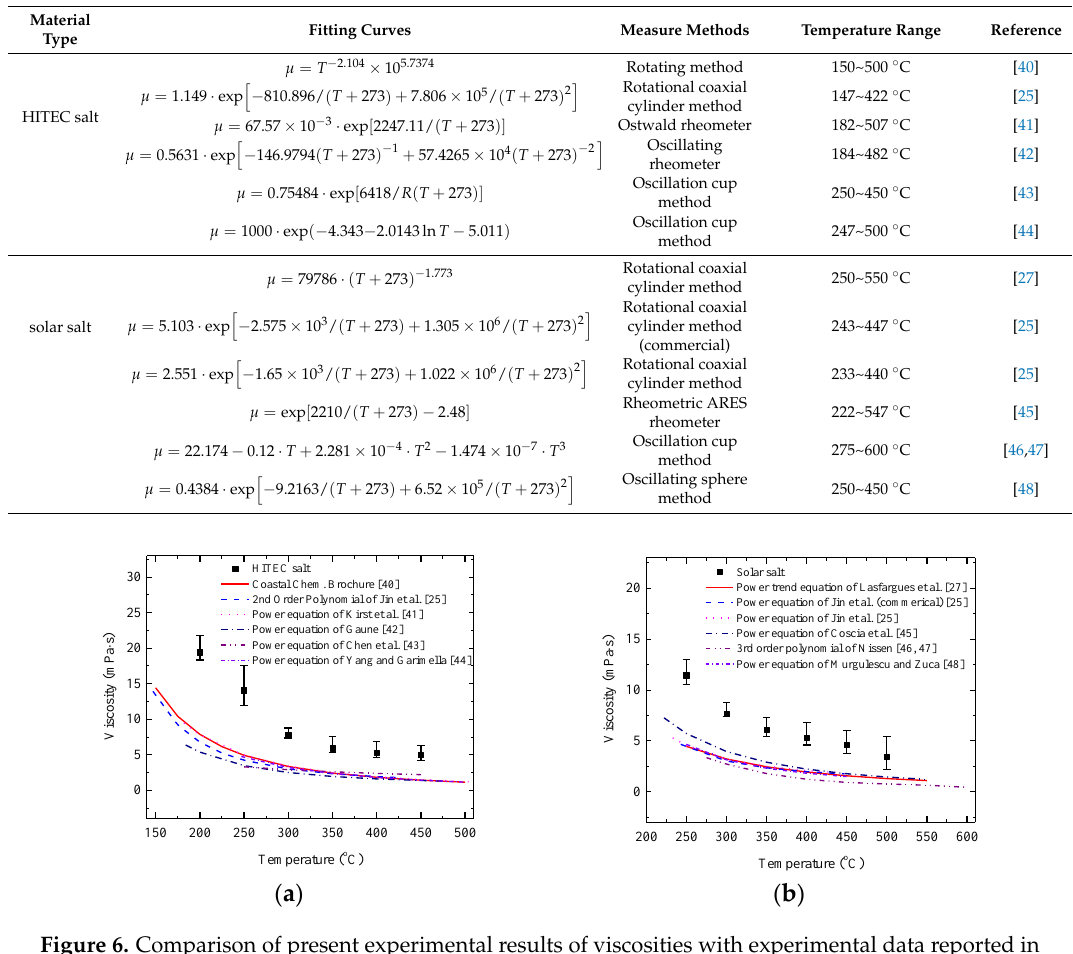
Table 2. Viscosities of salts varying with temperatures by fitting the following literature correlations Figure 5. Viscosities and shear stresses against different shear rates for solar salt. ( a ) viscosity (25 s − 1 [25,27,40–48]. to 100 s − 1 ), ( b ) shear stress (25 s − 1 to 100 s − 1 ), ( c ) viscosity (1 s − 1 to 25 s − 1 ), ( d ) shear stress (1 s − 1 to 25 s − 1 ).